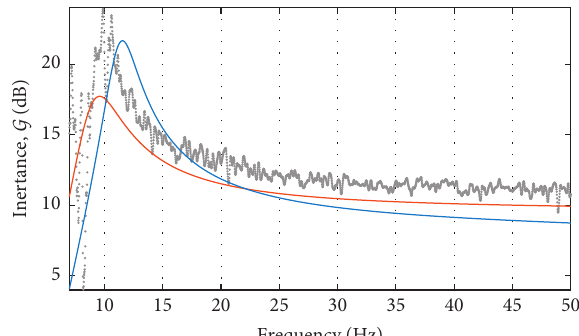
Figure 20: Inertances of the two underlying linear systems. Gray dots: measured inertance of the nonlinear test; blue line: NSI estimation of the linear inertance associated with the negative equilibrium z ∗ − ; orange line: NSI estimation of the linear inertance associated with the positive equilibrium z ∗ + .